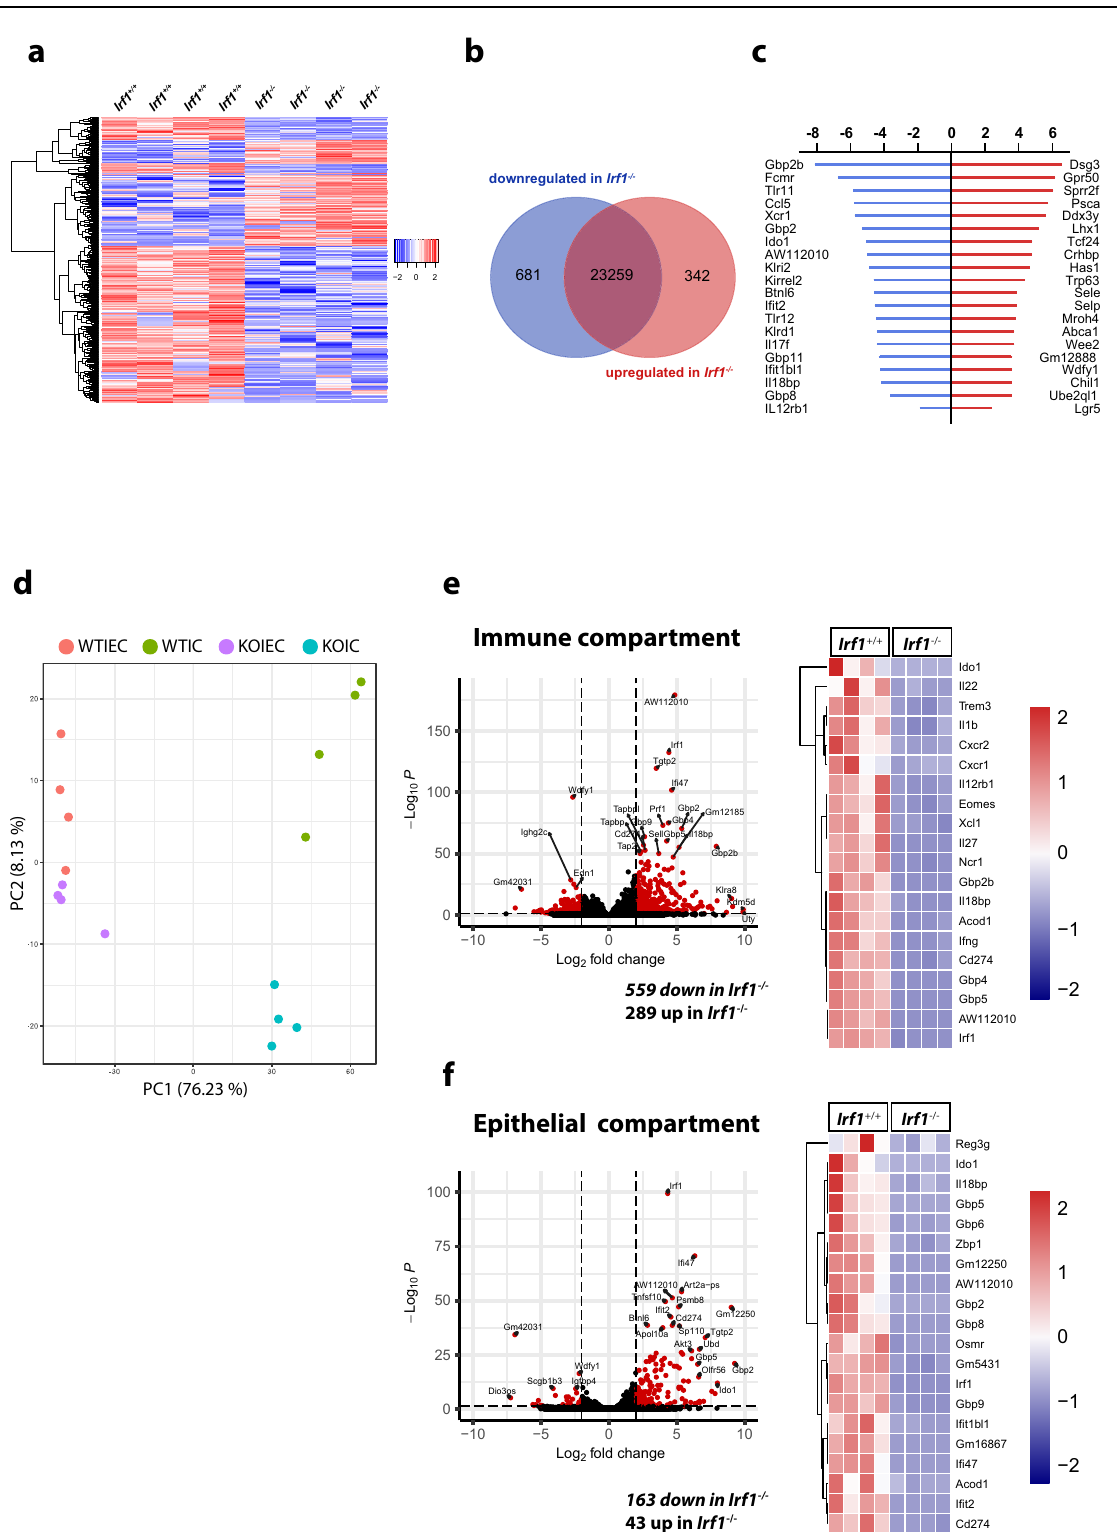
Fig.2|AnalysisofIrf1-dependenttranscriptionalchangesduringC.rodentium infection.a – c Expressionpro fi lingbybulkRNAseqofdistalwholecolonictissueof C. rodentium infected Irf1 – / – and Irf1 +/+ mice (9 dpi). d – f Colonic tissue of C. roden- tium infected mice (9 dpi) was removed and the epithelial and immune cell